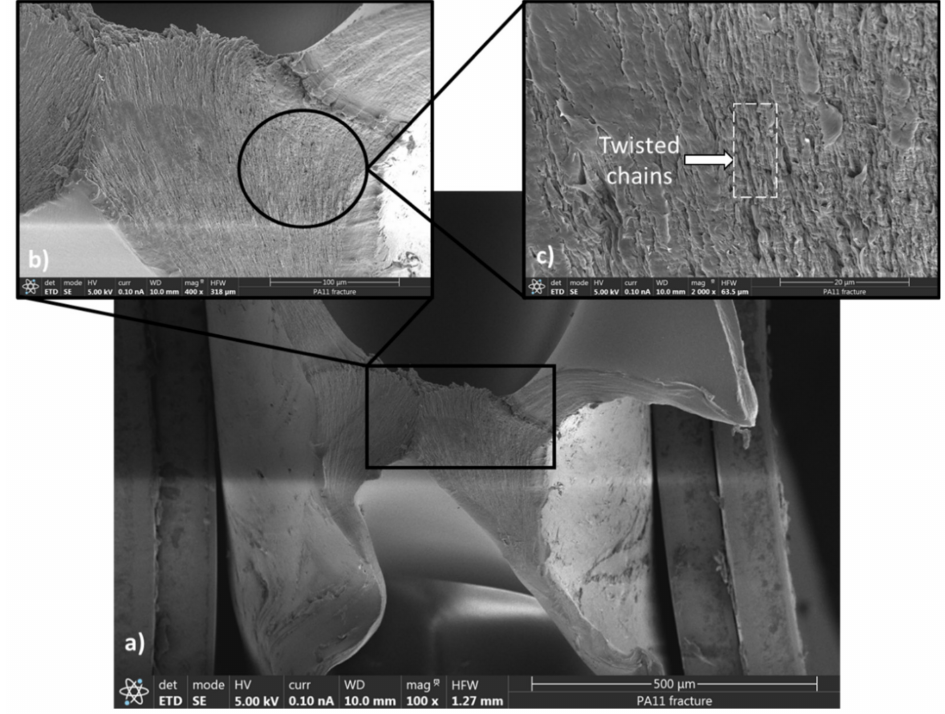
Figure 8. SEM micrographs of the PA11 fracture surface: ( a ) magnification of 100 × , ( b ) magnification of 400 × , ( c ) magnification of 2000 ×